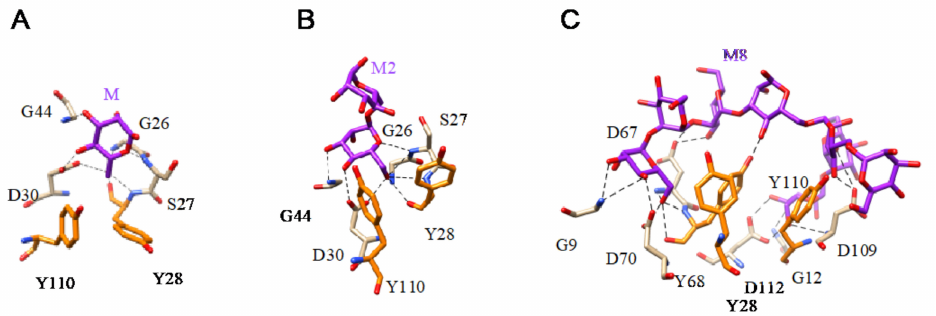
Figure 19. ( A ). Network of hydrogen bonds (black dashed lines) anchoring Man (M) to the amino acid residues forming the CBS of griffithsin (PDB code 2RDK). Aromatic residue Y28 and Y110 participating in stacking interactions with the pyranose ring of Man are colored orange. ( B ). Network of hydrogen bonds (black dashed lines) anchoring 6 α -mannobiose (M2) to the amino acid residues of the CBS of griffithsin (PDB code 2HYQ). Aromatic residue Y28 and Y110 involved in stacking interactions with the pyranose ring of the first Man residue are colored orange. ( C ). Network of hydrogen bonds (black dashed lines) anchoring a high-mannose branched glycan (M8) to the amino acid residues of the CBS of griffithsin (PDB code 3LL2). Aromatic residue Y28, Y68, and Y110, participating in stacking interactions with the pyranose rings of Man residues, are colored orange.